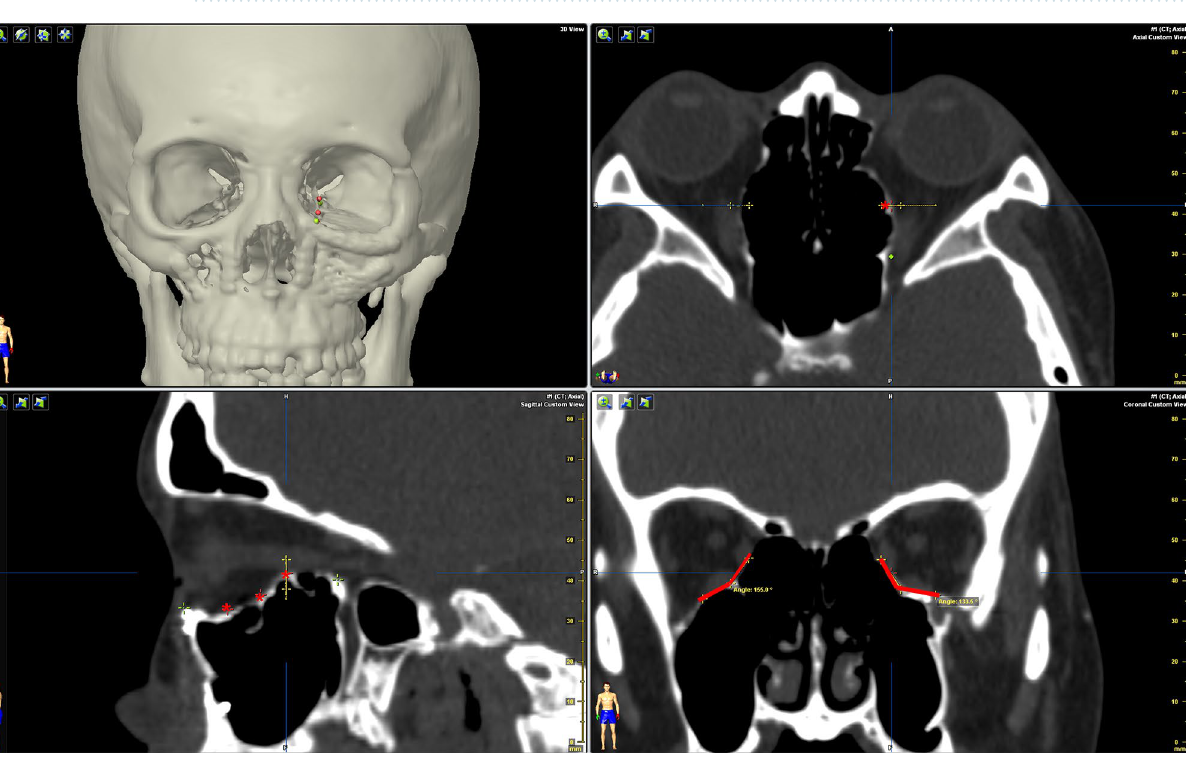
Figure 9. Measurements of bilateral angles of the transitional zone of the orbital buttress. The anterior, middle, and posterior points (red stars) are identified and evenly distributed on the orbital floor at the transitional buttress on the sagittal plane. The angles of the transitional buttress were measured on the coronal plane bilaterally. The figure shows that the bilateral angles of the posterior area are